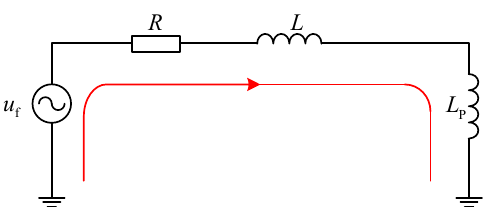
Figure 3. Simplified equivalent circuit of zero ‐ sequence DC component.